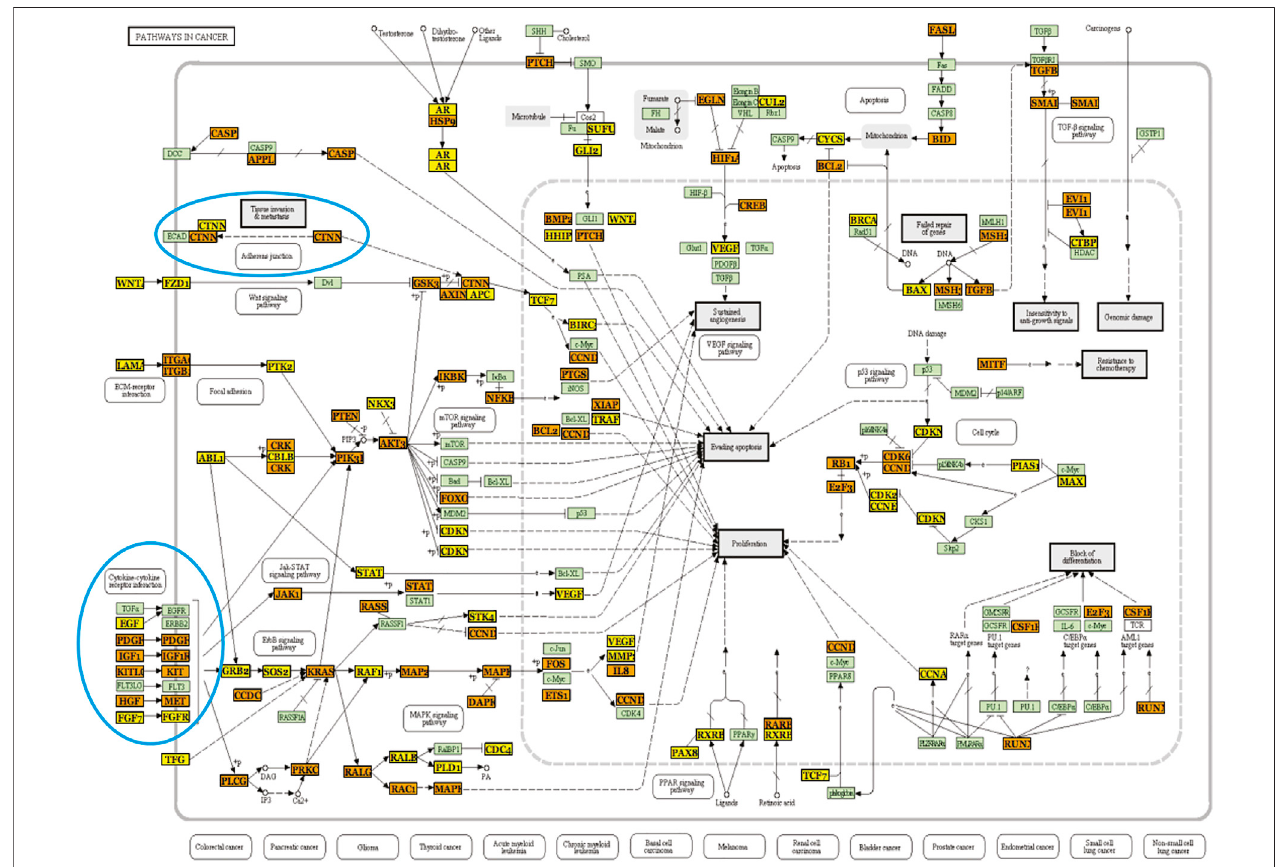
FIGURE 4 | A wiring diagram showing pathways in cancer and their regulation by microRNAs relevant in alcohol abuse. The diagram shows a network of several pathways important in the development of cancer. Gene products in yellow boxes are affected by one microRNA, gene products in orange boxes are affected by more than one microRNA. Gene products in green boxes are unaffected. Elements of pathways in blue circles were tested by qPCR ( Figure 2 ). Wiring diagrams of speci fi c cancers are available in the Supplementary Materials. The wiring diagram was created using KEGG (Kyoto Encyclopedia of Genes and Genomes) and DIANA- mirPath software with FDR correction and p -value threshold of 0.05.